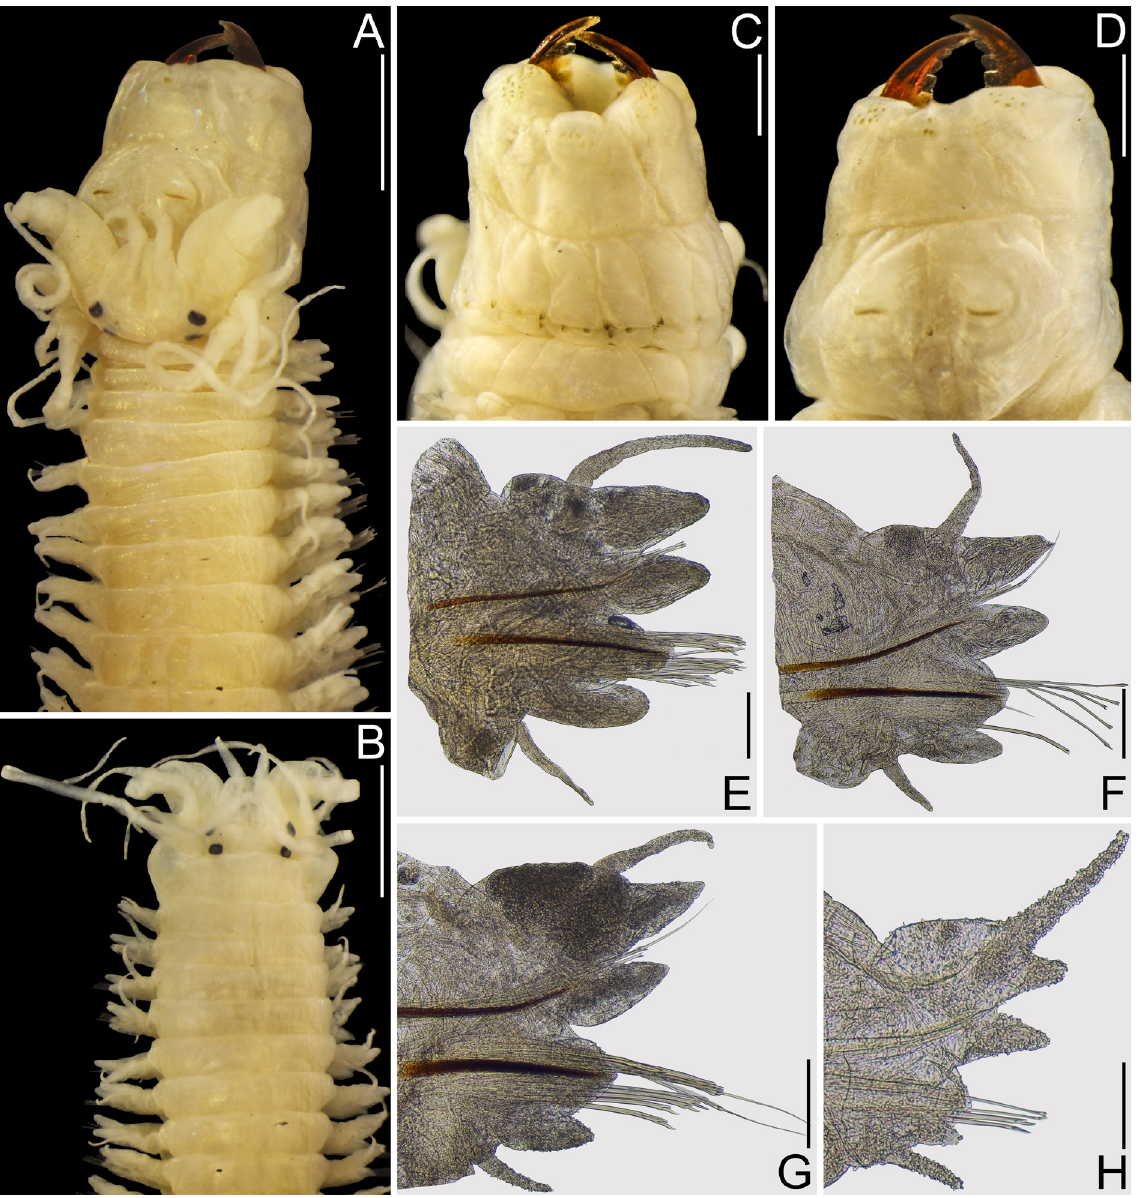
Fig. 7. Perinereis websteri sp. nov. Non-types (USNM 1660577, from syntype series of Nereis bairdii Webster, 1884). A . Anterior end, dorsal view. B . Anterior end, dorsal view. C . Pharynx, dorsal view. D . Same, ventral view. E . Chaetiger 10, left parapodium. F . Chaetiger 43, left parapodium. G . Chaetiger 69, left parapodium. H . Chaetiger 84, left parapodium. Scale bars: A–B = 1 mm; C–D = 0.5 mm; E–G = 0.2 mm; H = 0.1